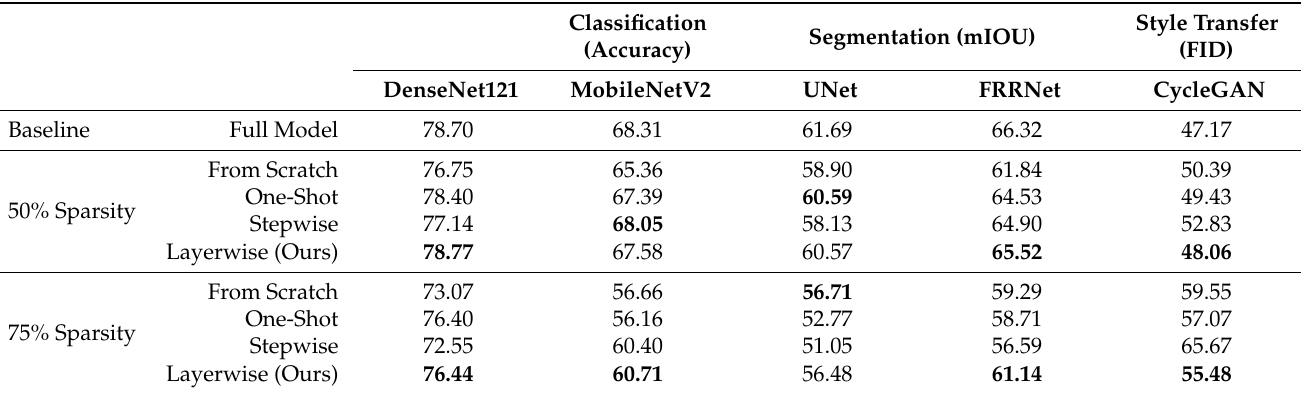
Table 1. Comparing pruning schedules across discriminative and generative tasks. With higher levels of sparsity, our greedy layerwise channel pruning algorithm performs better than existing baselines across both discriminative and generative tasks. Note that for top-1 accuracy and mIOU, higher is better, but for FID, lower is better.